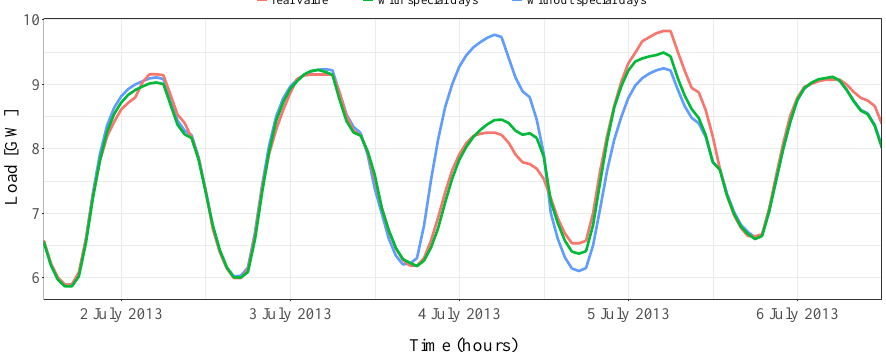
Figure 11. Special day effect for the example of Independence Day (4 July 2013), for NYC